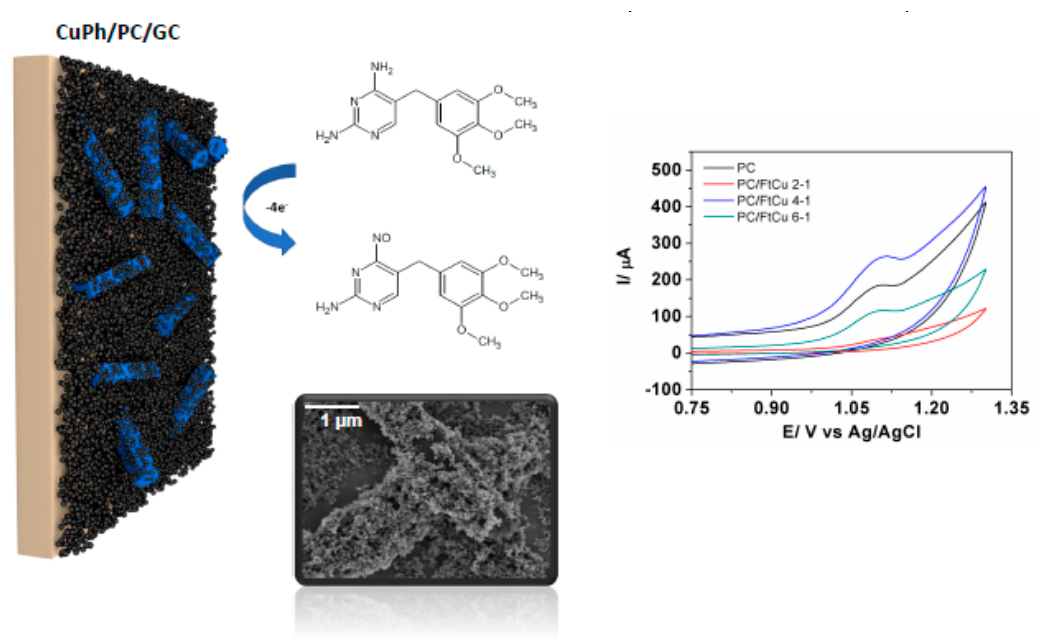
Figure 4. A trimethoprim antibiotic sensor composed of Printex L6 carbon black (CB) and copper (II) phthalocyanine films (reproduced from [138], with permission from Elsevier, 2018).